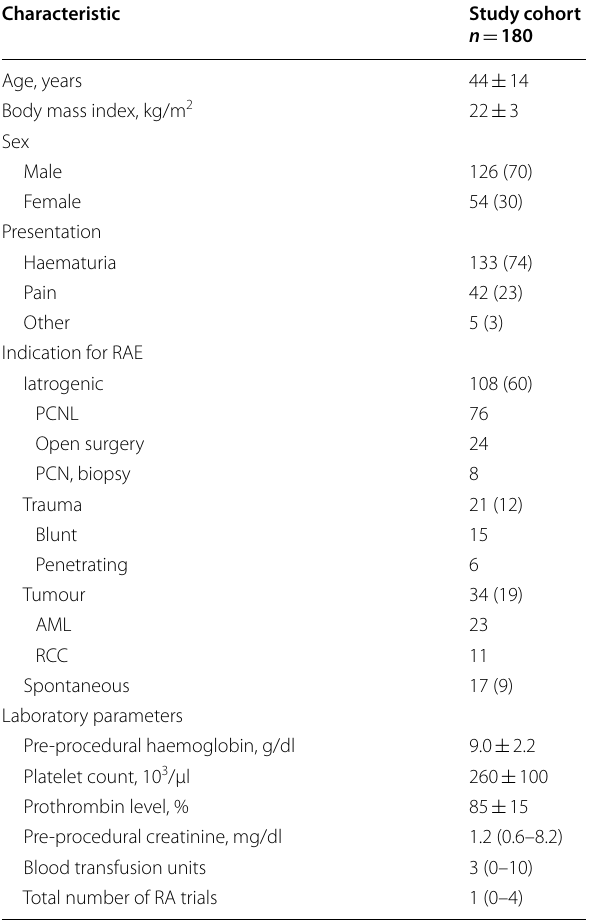
Table 1 Demographic and clinical characteristics of